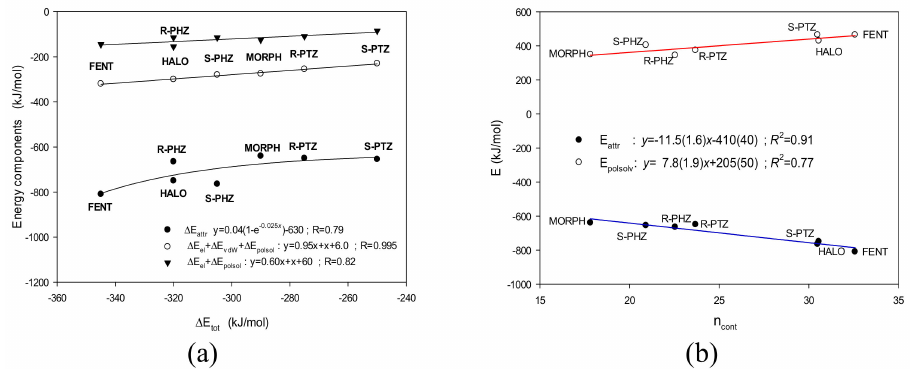
Figure 5. ( a ) Contribution of the most important energy terms to the total energy. ( b ) The attractive energy term ∆ E attr and the repulsive energy term ∆ E polarsol as a function of the number of contacts n cont for the studied